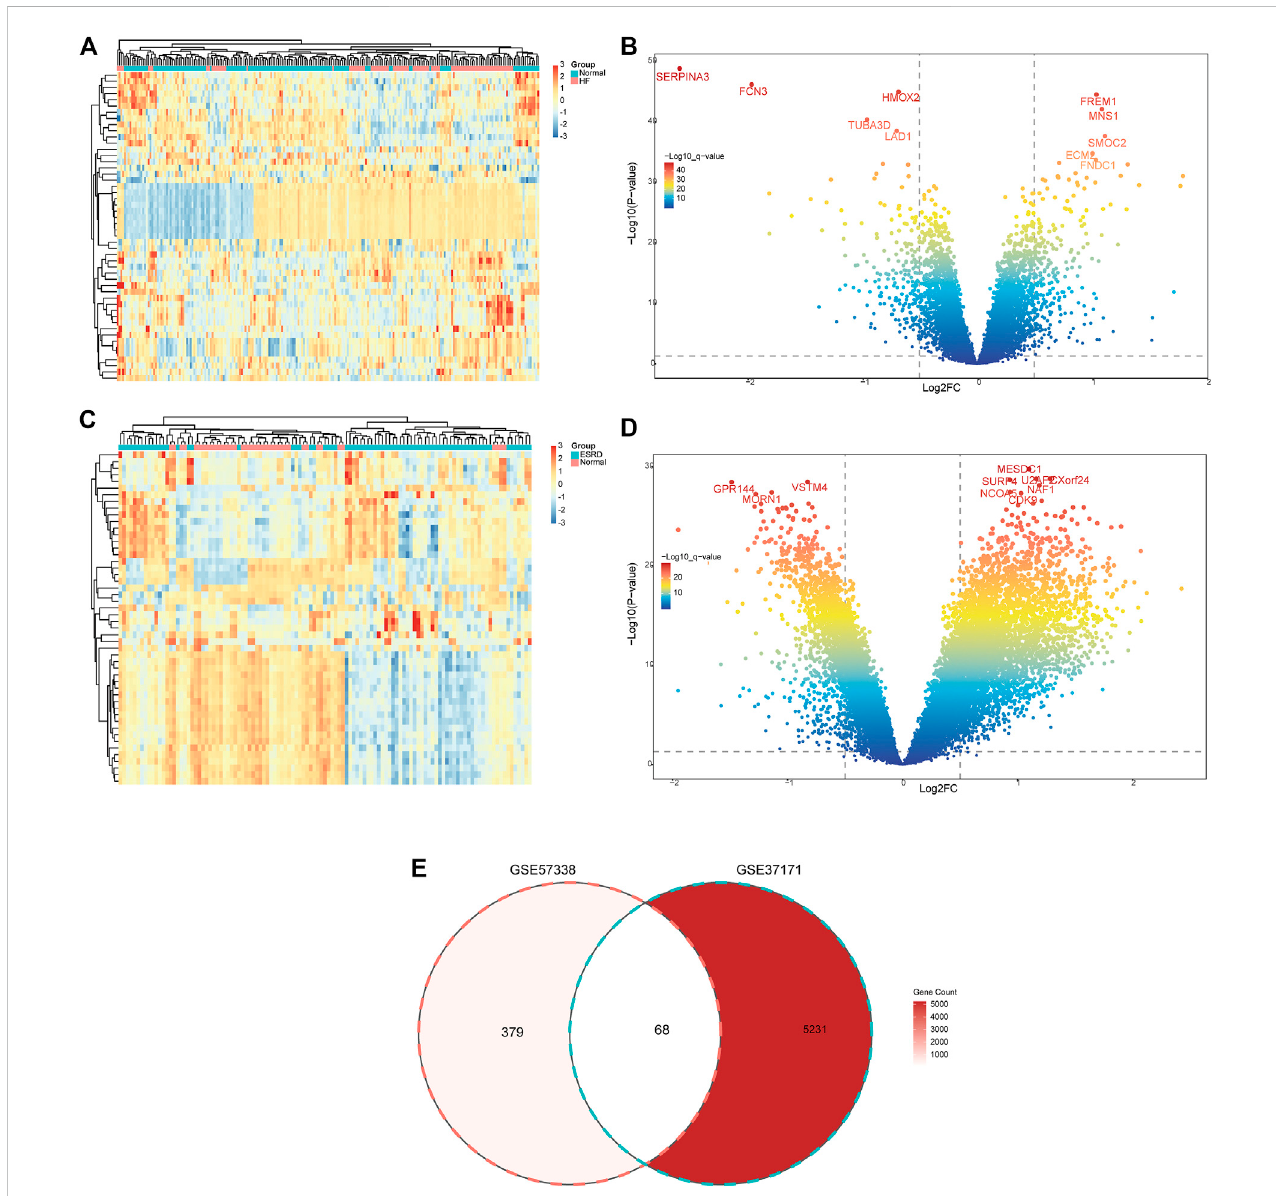
FIGURE 2 Identi fi cation of common DEGs. (A) Heatmap of the top 50 DEGs in GSE57338. (B) Volcanic plots of GSE57338. (C) Heatmap of the top 50 DEGs in GSE37171. (D) Volcanic plots of GSE37171. (E) Venn diagram of common DEGs in HF and ESRD. HF, heart failure; ESRD, end-stage renal